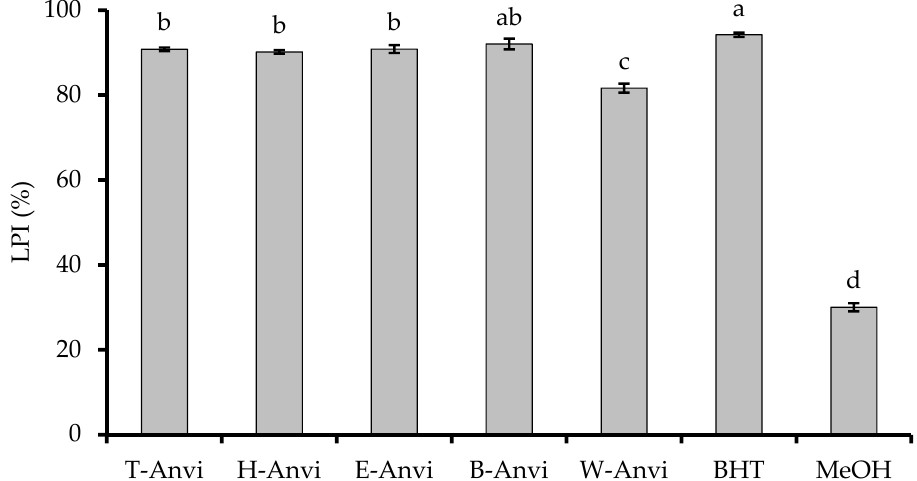
Figure 1. Inhibition on lipid peroxidation of A. virginicus extracts. Different letters indicate significant differences at p < 0.05. LPI, lipid peroxidation inhibition; T-Anvi, total crude extract; H-Anvi, hexane extract; E-Anvi, ethyl acetate extract; B-Anvi, butanol extract; W-Anvi, water extract; BHT, butylated hydroxytoluene.